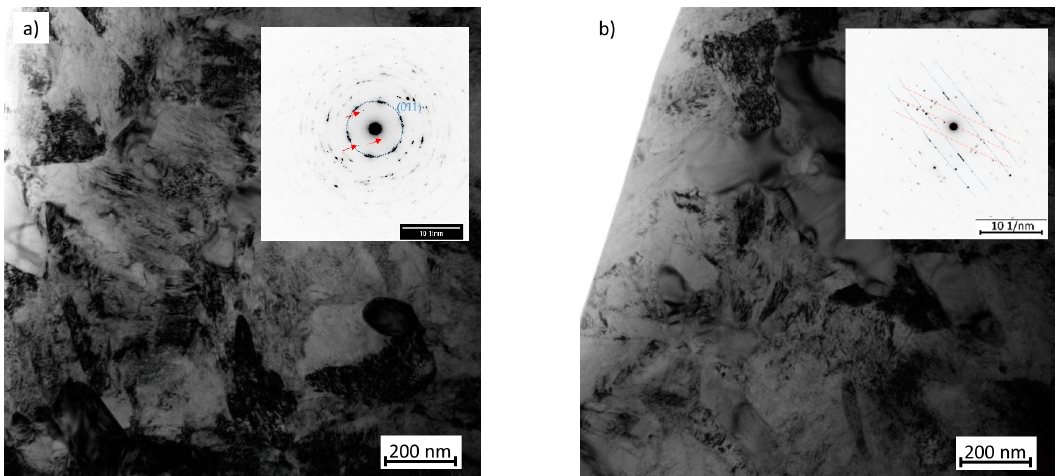
Figure 10. Regime 1: 1200 °C/water: ( a ) BF (bright-field) micrograph, particles of Fe 3 C cementite and carbides are visible in the ferritic-martensitic matrix; the inset shows the related SAED pattern with a marked circle associated with the (011) α Fe reflections, the sharp spots outside the circle indicate carbides (marked with an arrow); ( b ) region with a vast number of Fe 3 C cementite and Cr 23 C 6 carbide particles with their SAED pattern in which Fe 3 C cementite spots are marked in blue and Cr 23 C 6 carbide spots in red.